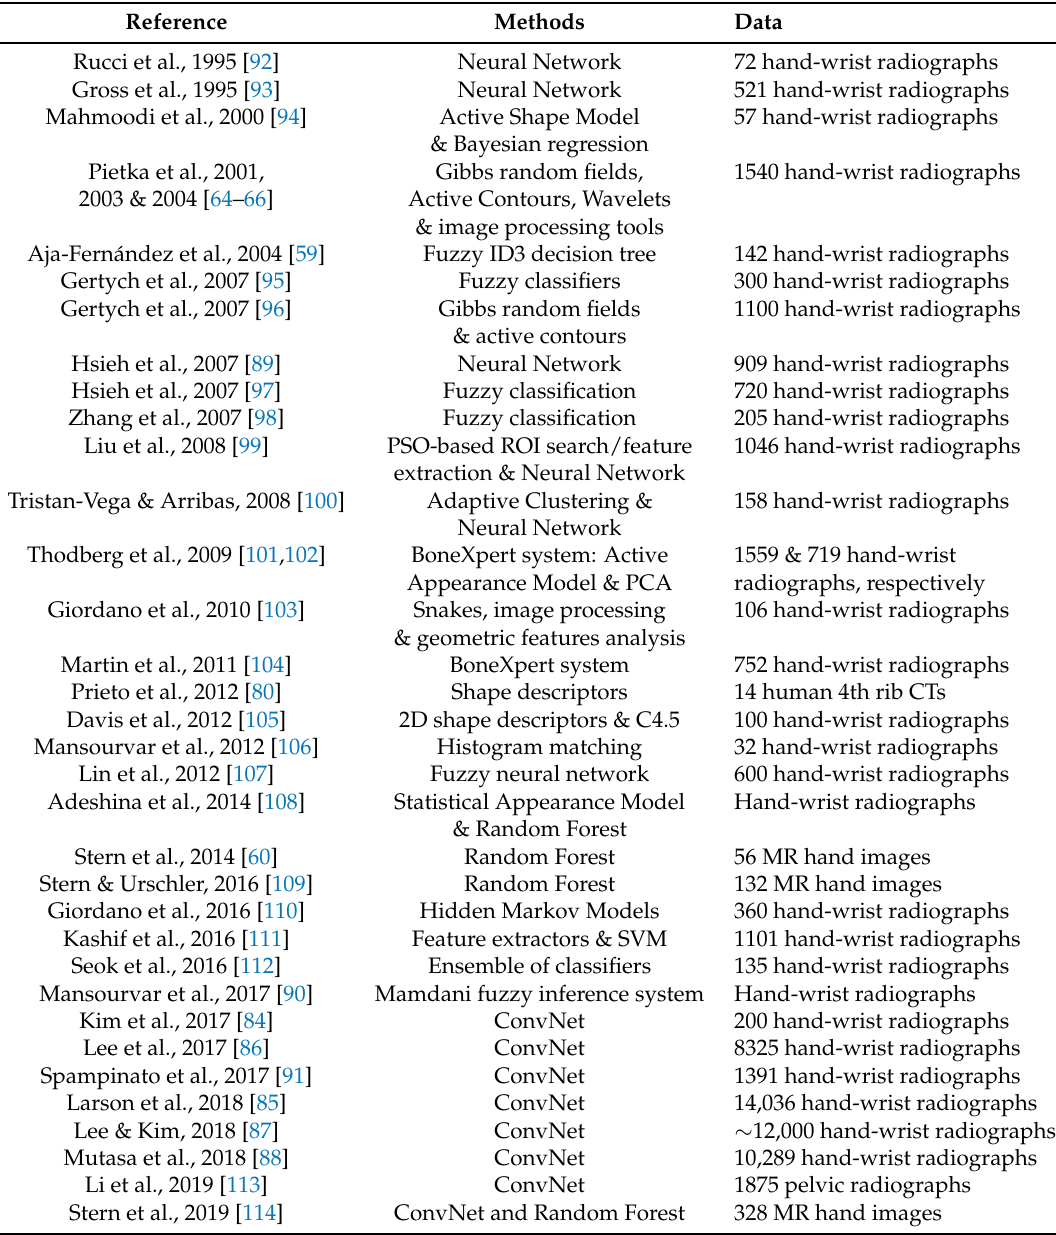
Table 2. An overview of the literature on AI-based approaches for age estimation from skeletal data. References are ordered according to their publication